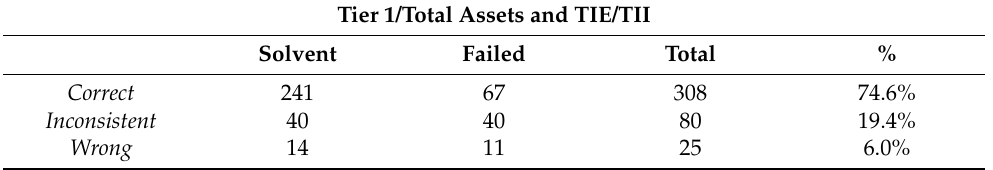
Table 6. The labeling of the multivariate